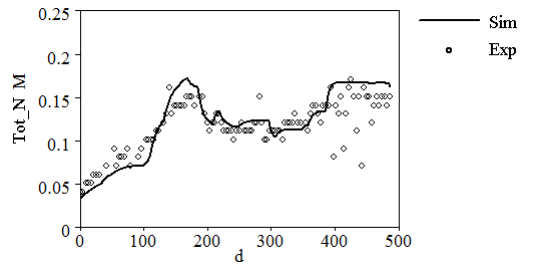
Figure 7: Simulated and experimental total ammonia